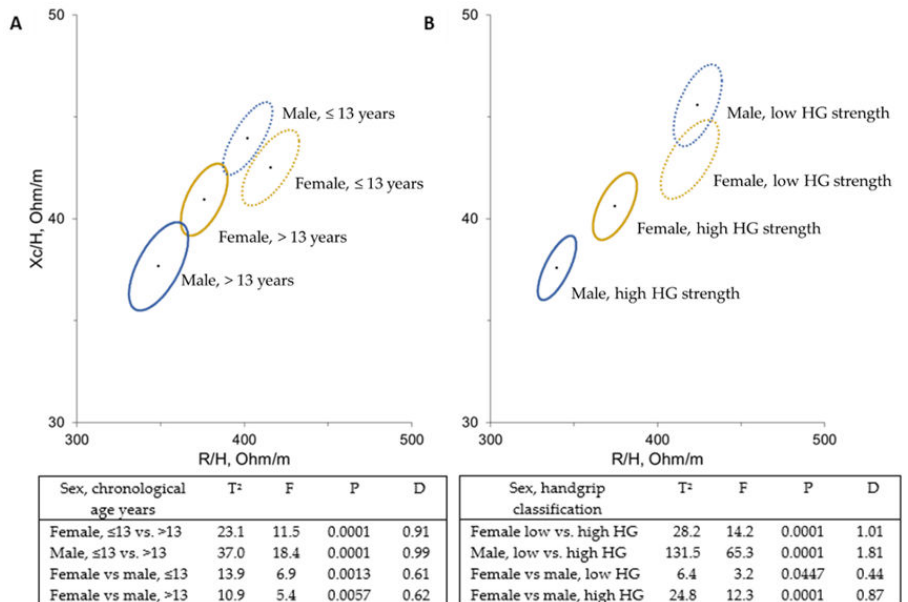
Figure 3. Mean impedance vectors with the 95% confidence ellipses for adolescent athletes sorted by chronological age ( A ) or handgrip strength classification ( B ). Mahalanobis distances (D), Hotelling T 2 -tests, F and p -values are included.